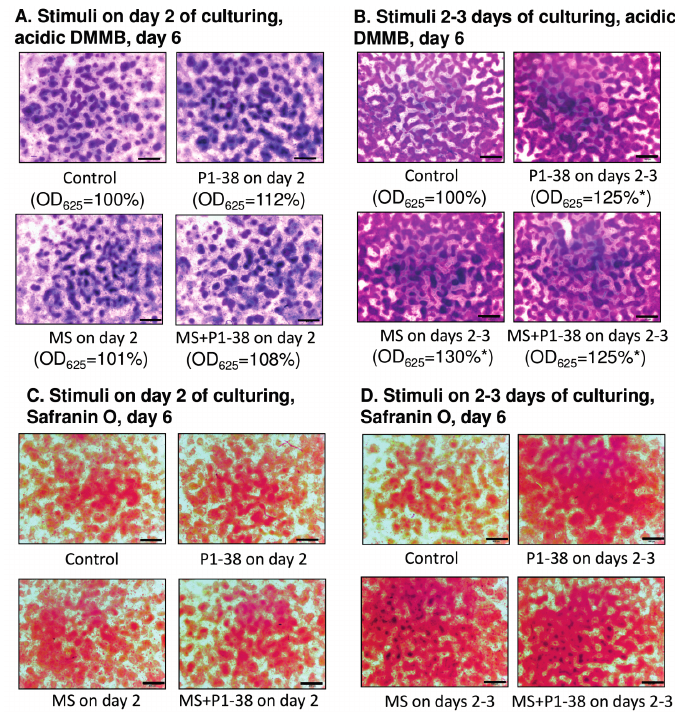
Figure 1. Effects of PACAP and/or mechanical load on matrix production of HDC.